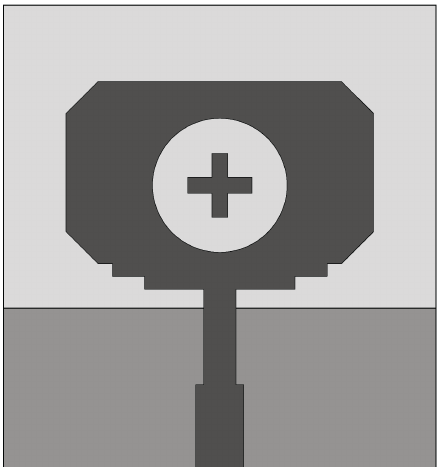
Figure 15. Design of a modified octagonal shape UWB monopole (redrawn from [72]). Dark gray top metal face, medium gray bottom metal face, and light gray dielectric